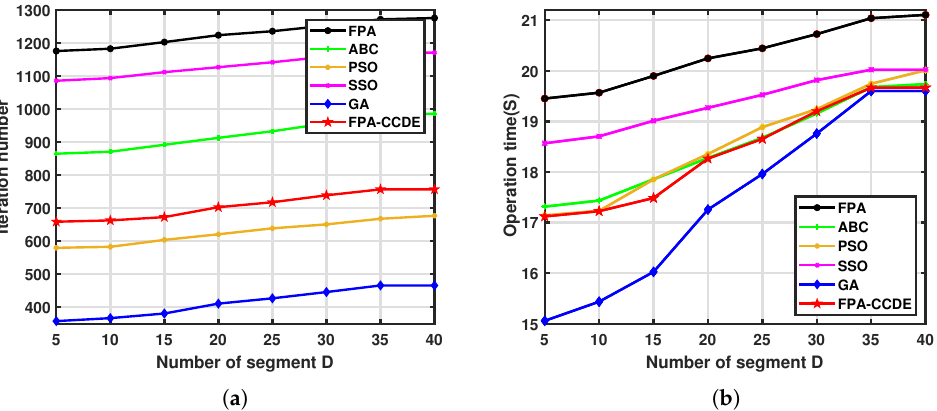
Figure 8. Iterations and operation time under different algorithms with various segments: ( a ) itera- tions under different segmentation; ( b ) running time under different segmentation.